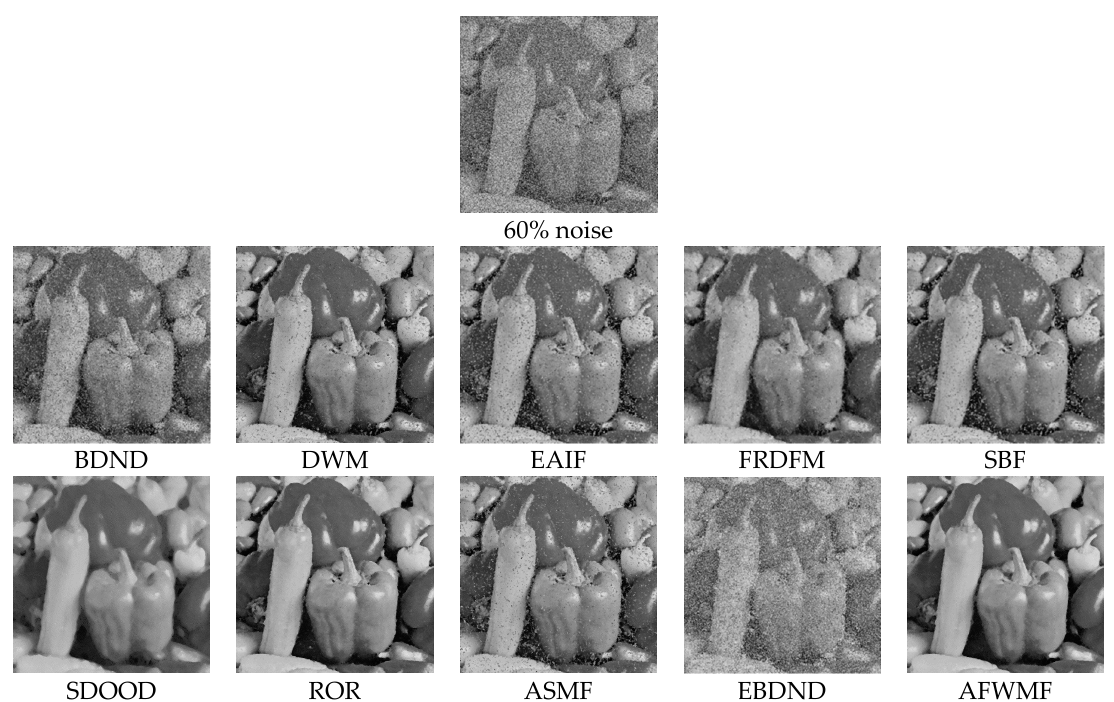
Figure 14. Repair map with a 60% random value of impulse noise for the Peppers image.